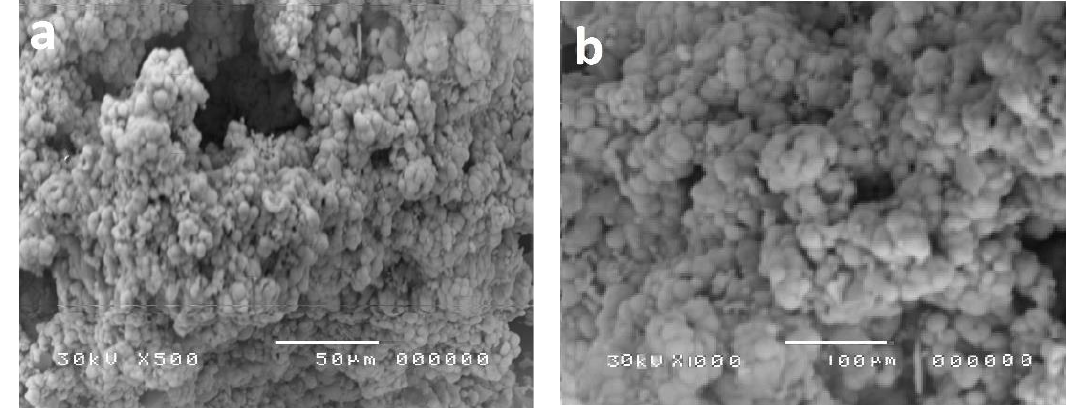
Figure 4. SEM graphs of the selected metal oxide nanoparticles (nMOx = ( a )WO 3 /( b )ZnO)